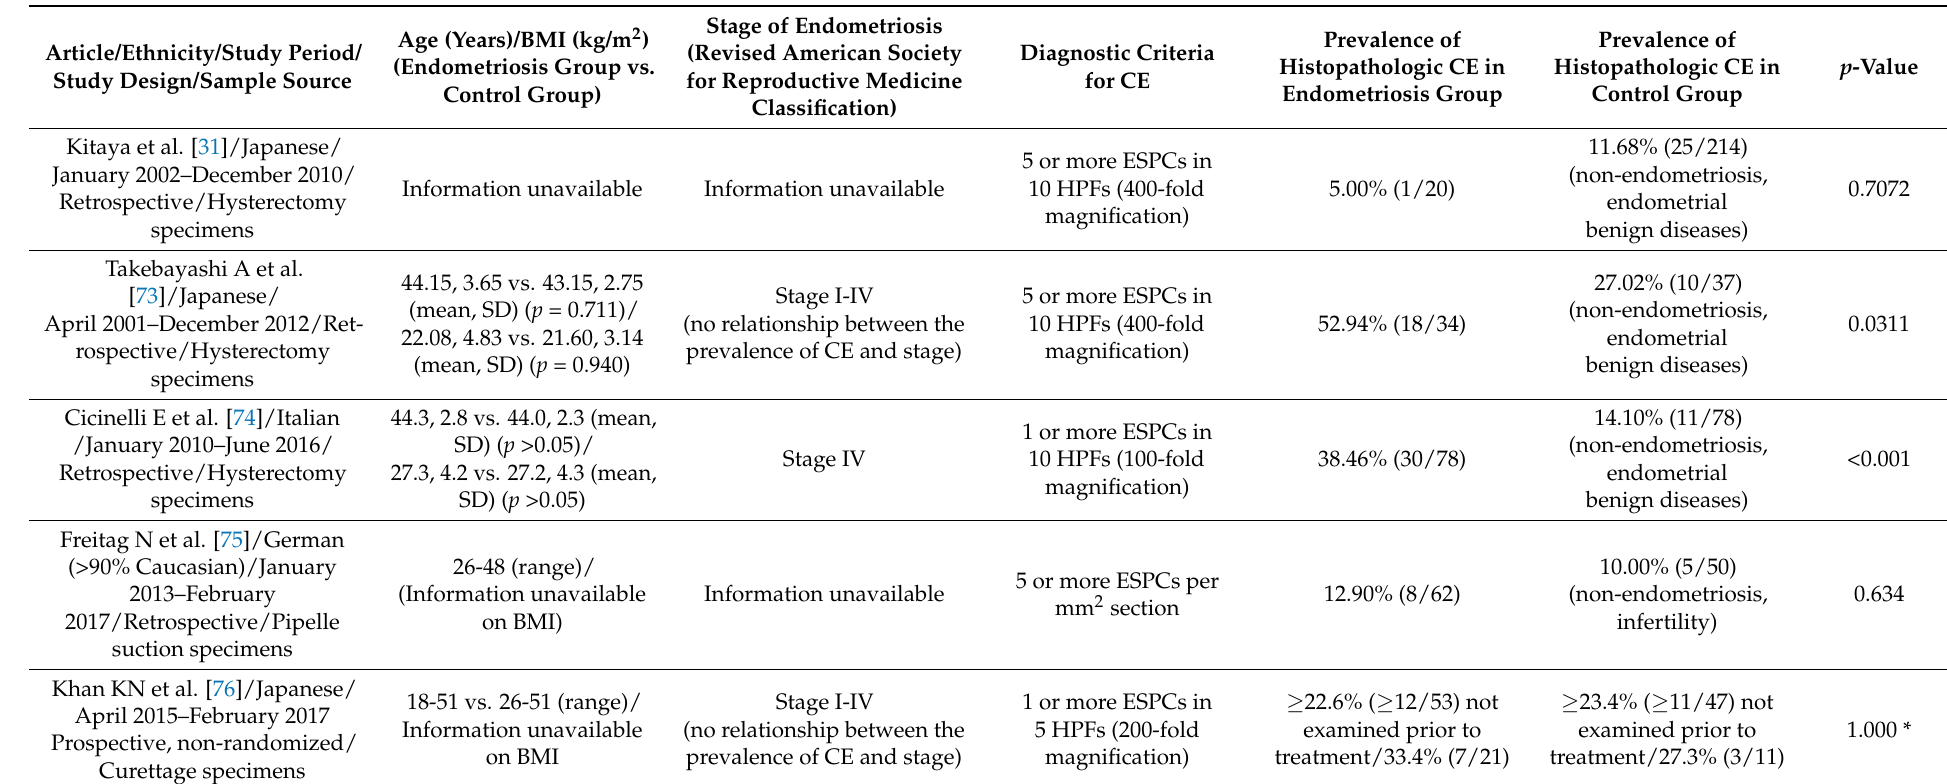
Table 2. Publications on the relationship between histopathologic CE and